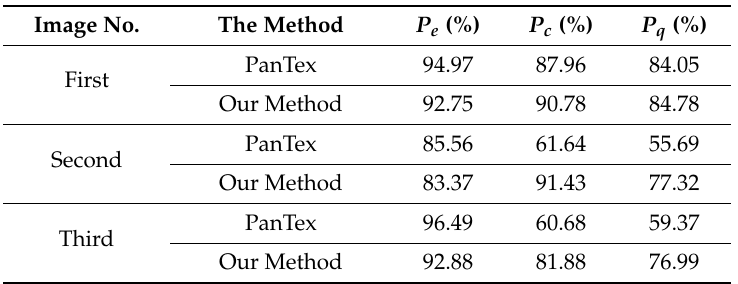
Table 5. Statistics of the performance of two built-up extraction